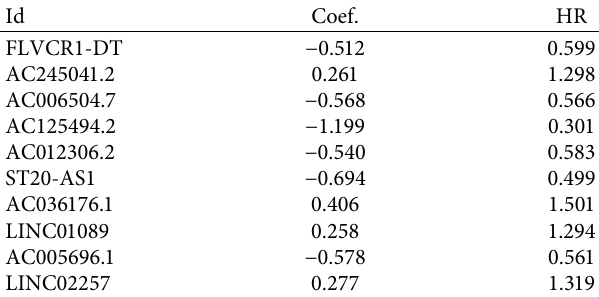
Table 2: Multivariate Cox regression analysis of 10